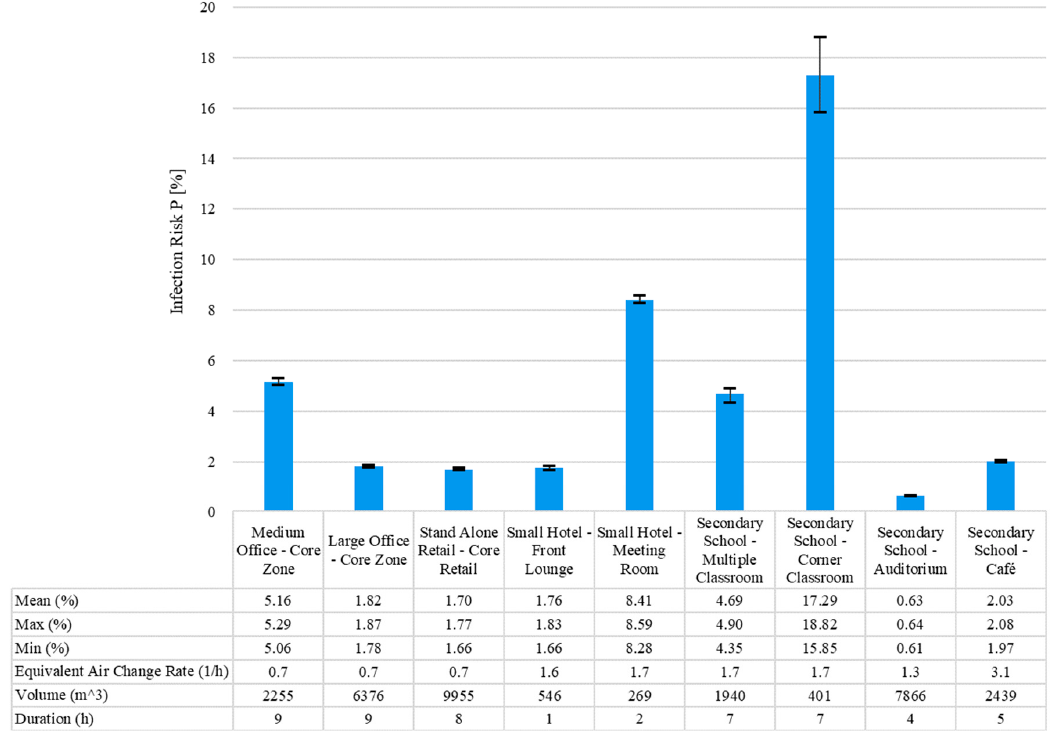
Figure 12. Individual infection risk P [%] for baseline cases for evaluated DOE commercial prototype buildings. The height of the column is the mean risk value; error bars are maximum and minimum values.